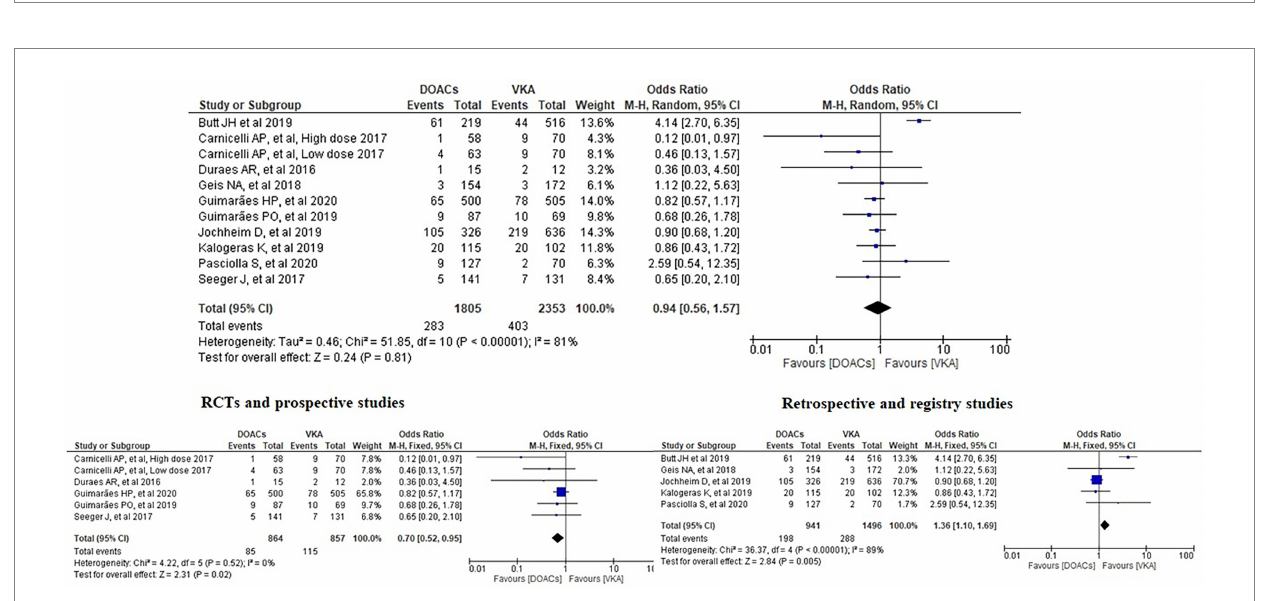
FIGURE 5 Forest plot of bleeding for DOACs compared with VKA along with subgroup analysis. M-H, Mantel–Haenszel test; CI, confidence